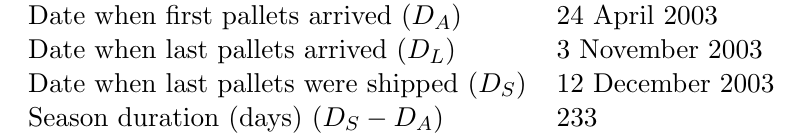
Table 4: Event dates of pallet arrivals and departures at FPT